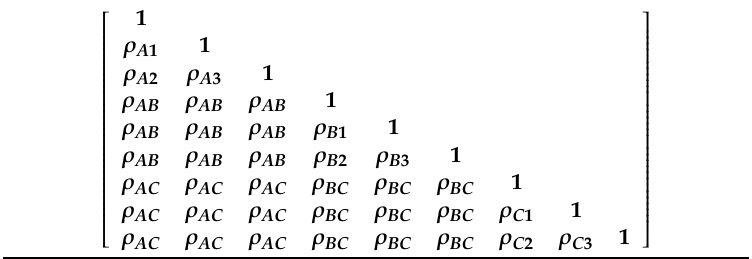
Table 1. Parameterized cross-correlation structure of the latent traits for